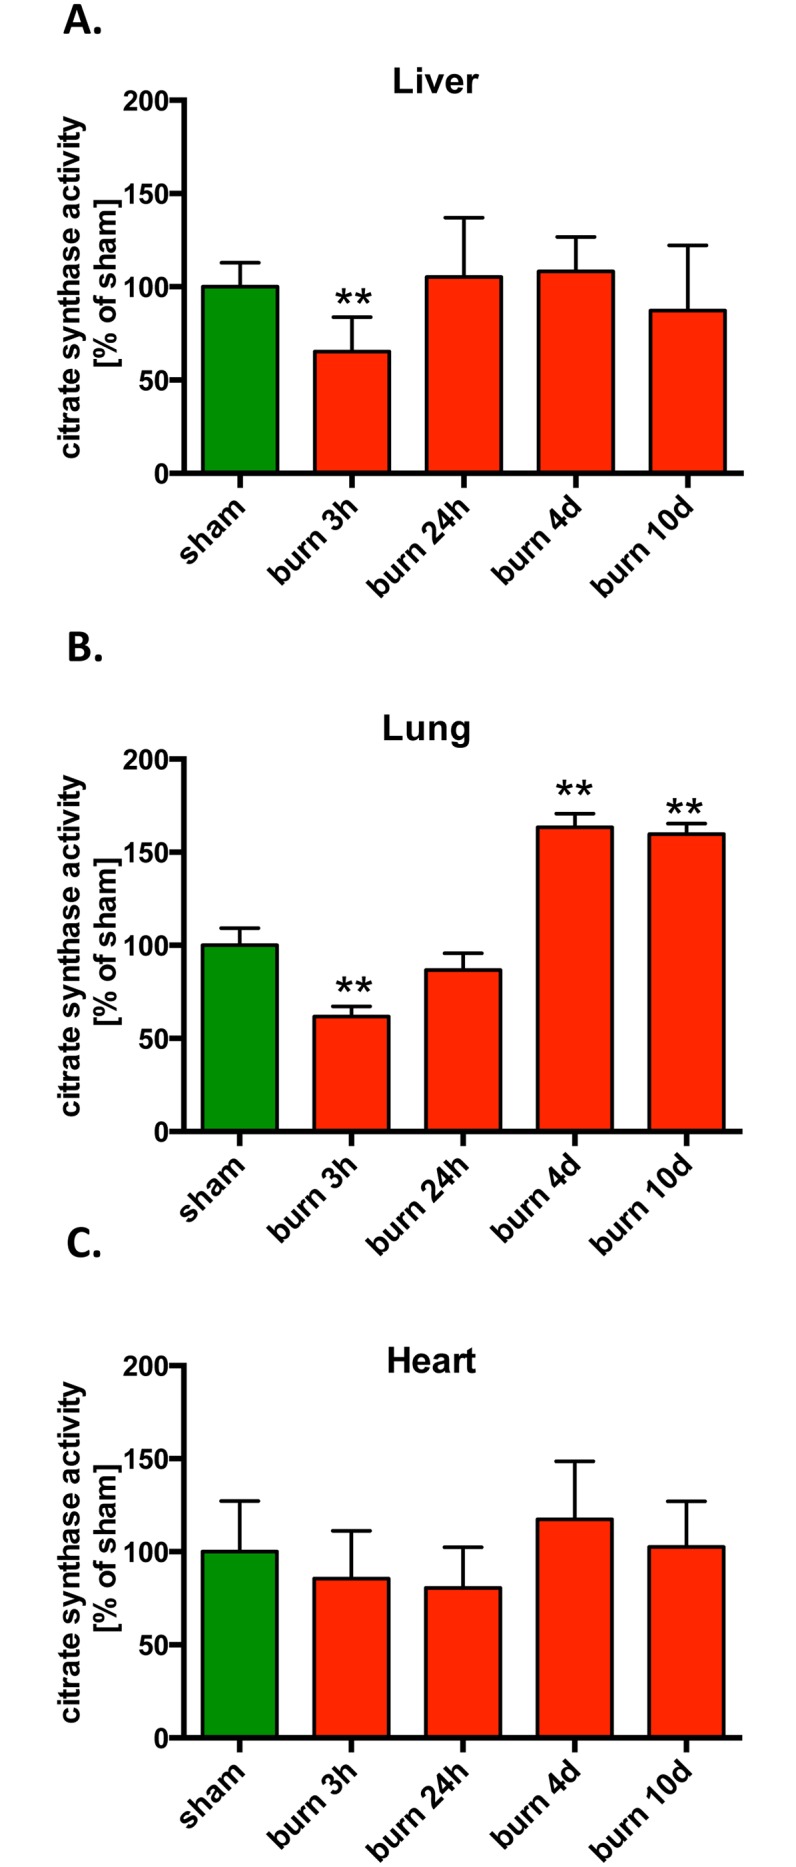
Changes in mitochondrial volume in response to burn injury.Mitochondrial biogenesis was assayed using specific activity of citrate synthase in extract isolated from (A) liver, (B) lungs and (C) heart of mice subjected to burn injury. The results are based on n = 6 per group and represent mean±SD. ** p<0.01, relatively to sham animals.